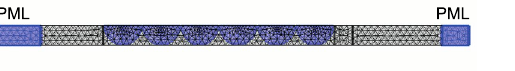
Figure 4. Top view of the numerical domain, exhibiting the tetrahedra elements, Perfectly Matched Layers (PML) locations, and the quarter